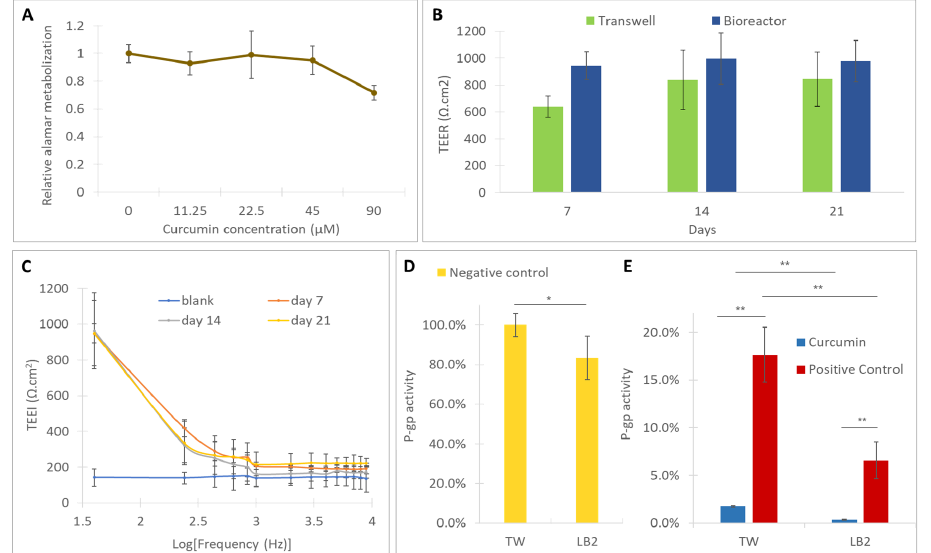
Figure 4. ( A ) Cell vitality, with respect to the 0 µM control, for different concentrations of curcumin after 48h of incubation; barrier monitoring through ( B ) trans epithelial electrical resistance (TEER) in the bioreactors and Transwells, ( C ) trans epithelial electrical impedance (TEEI) in the bioreactors at different timepoints; ( D ) P-gp activity in untreated samples (negative controls); ( E ) P-gp activity modulation by curcumin and arylmethyloxy-phenyl derivative (APD) (positive control) in Transwells and in the bioreactors. Error bars represent the standard deviations (n = 6). * = p < 0.05, ** = p <